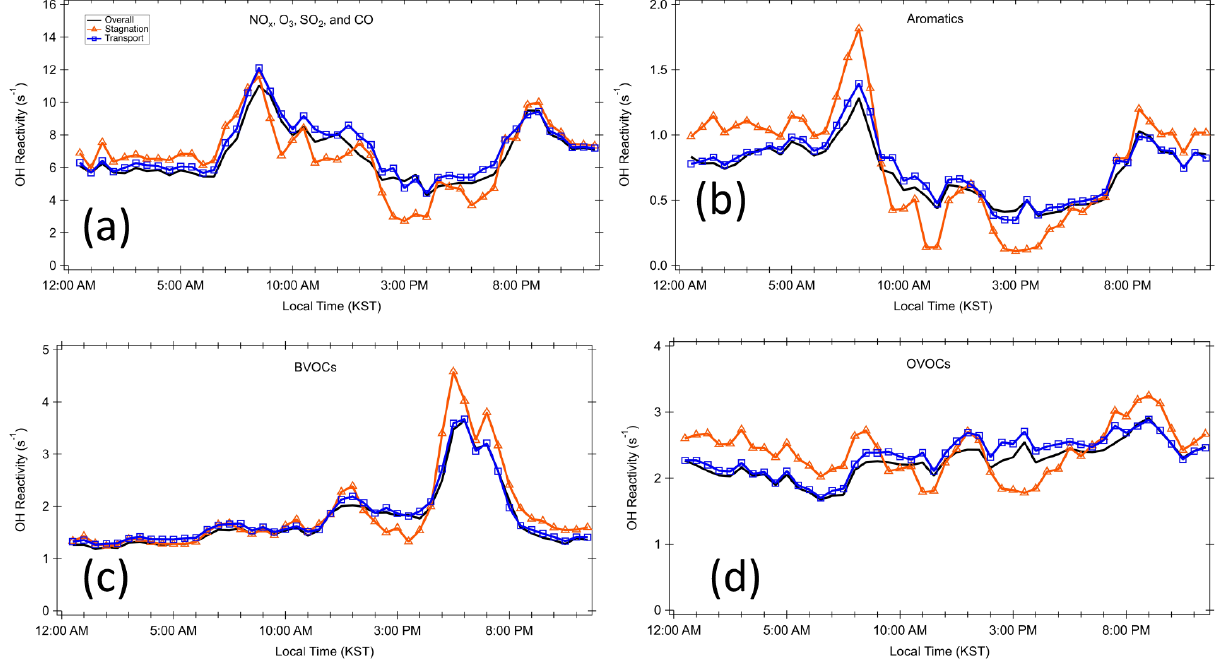
Figure 5. Diurnal profiles for different classes of trace gases during the different periods. (a) Criteria pollutants NO x , O 3 , SO 2 , and CO; (b) aromatics; (c) BVOCs; and (d) OVOCs.